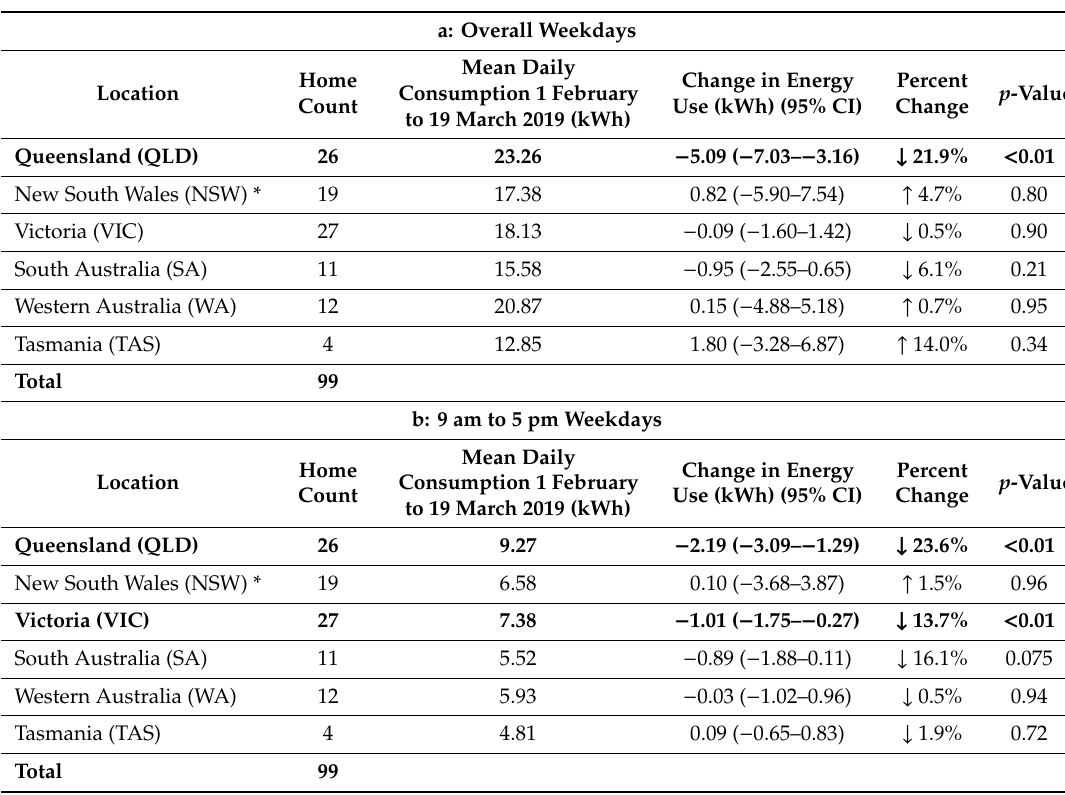
Table 4. (a,b) Significant changes in energy use from 1 February to 19 March 2019 compared to 21 March to 8 May 2019 from smart inverter data: overall use during weekdays (a), and 9 am to 5 pm weekdays only